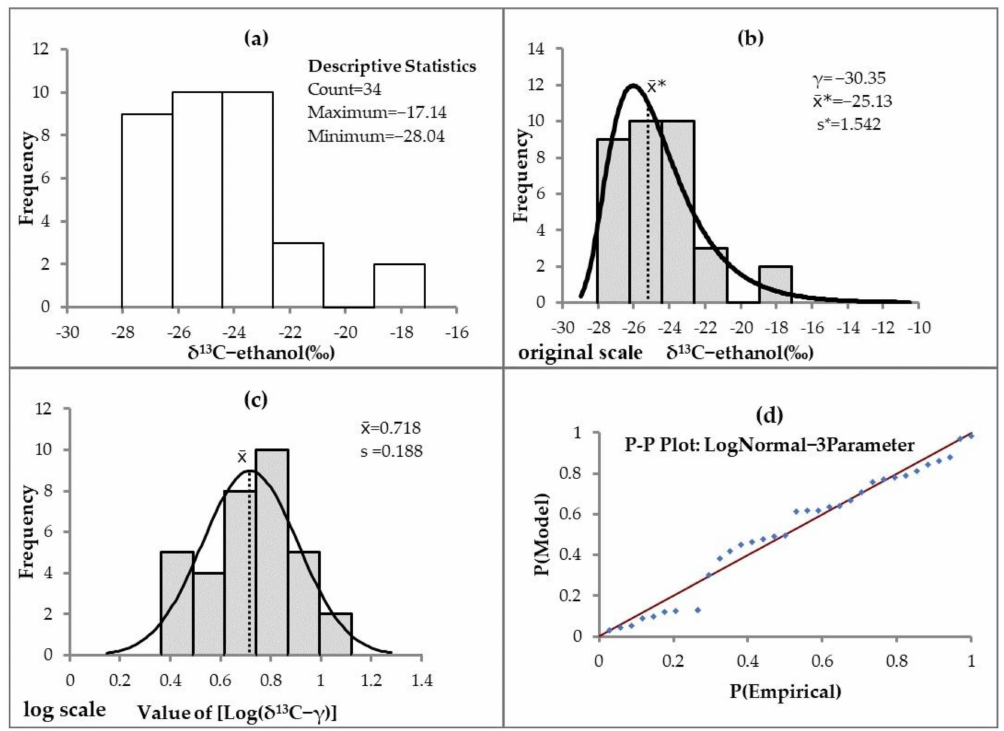
Figure 3. Statistical evaluating results of authentic blended Scotch whisky. ( a ) The histogram of δ 13 C-ethanol. ( b ) The distribution of observed δ 13 C − ethanol. ( c ) The distribution of transformed δ 13 C − ethanol. ( d ) The P-P plots of δ 13 C −